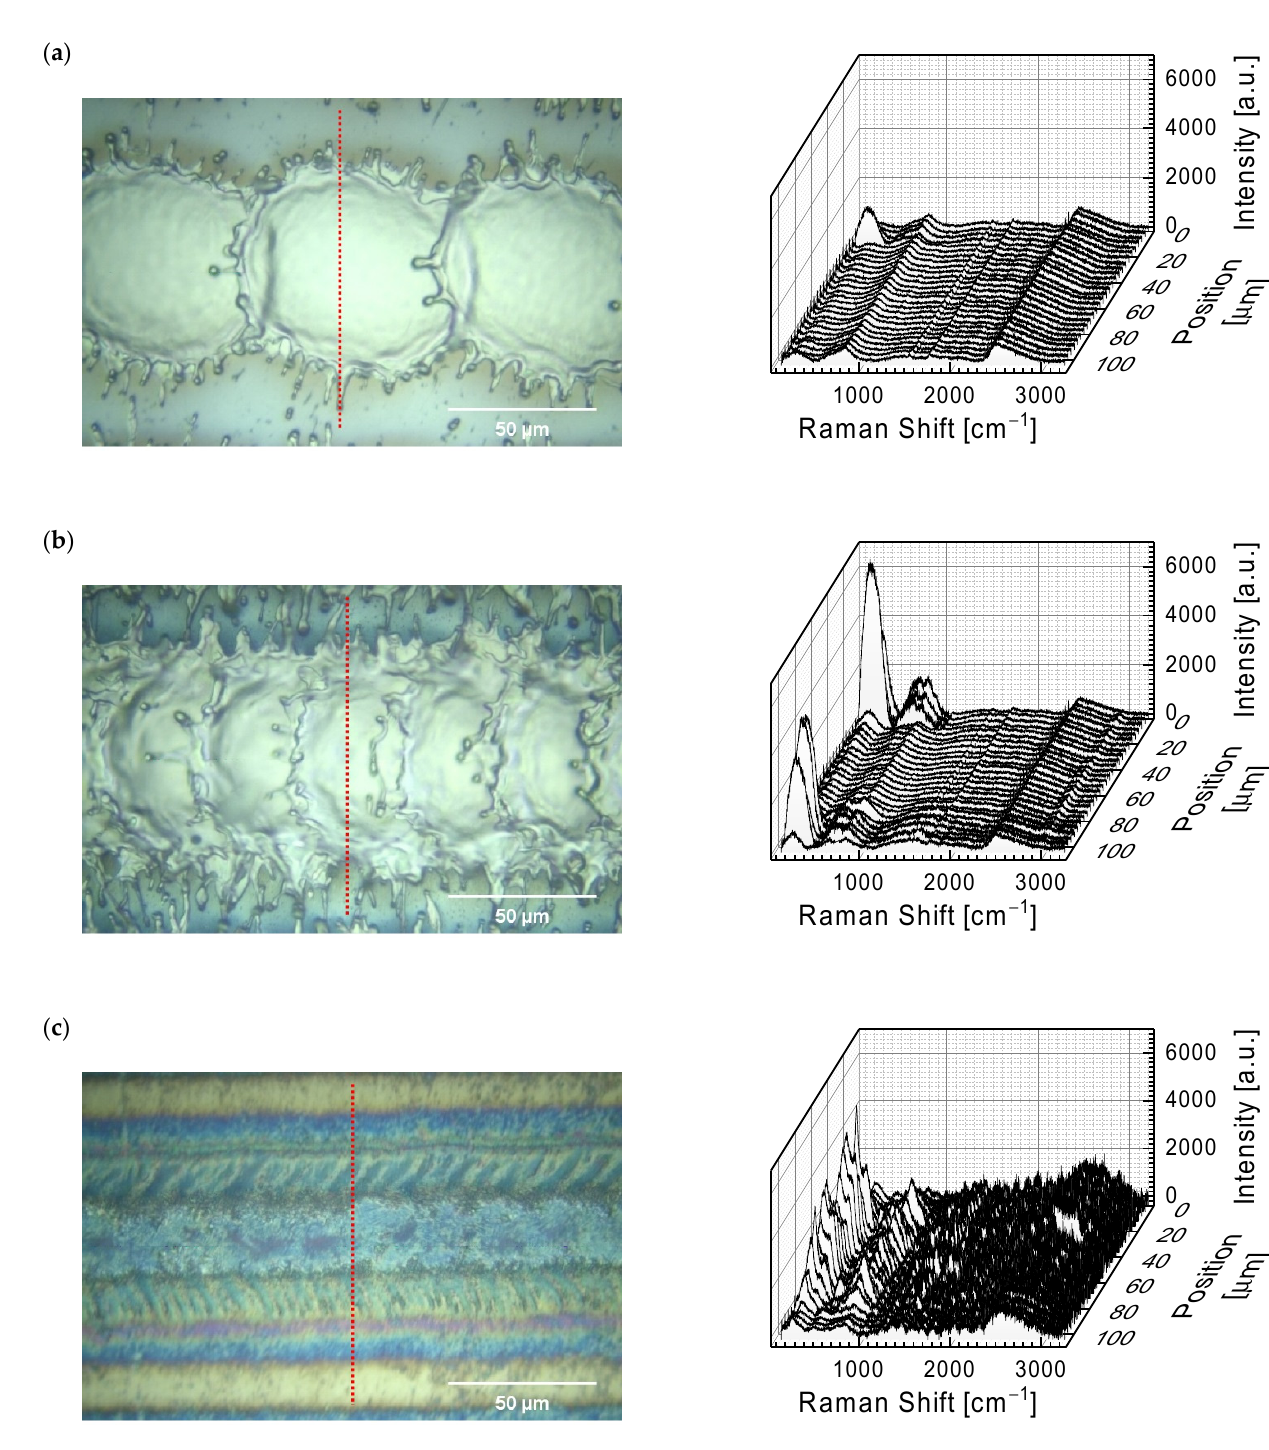
Figure 4. Raman spectra profiles measured after laser processing with an average power of 12 W and a hatch distance of 100 µm in the case of ( a ) pulse mode with a scanning speed of 2400 mm/s, ( b ) pulse mode with a scanning speed of 1200 mm/s, and ( c ) continuous wave with a scanning speed of 75 mm/s. In the photos, the dotted red line shows the place where the Raman spectra were collected (where 0 µm denotes the top of the line and 100 µm the bottom of the line) at 4 µm intervals.